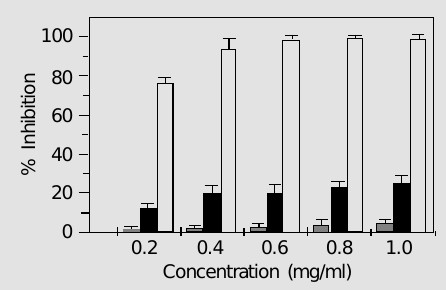
Figure 2. Inhibitory effect of Polypodium leucotomos extract (PL) and kojic acid (KA) (0.0 to 1.0 mg/ml) on the reduction of nitroblue tetrazolium by super- oxide anion radical ( · O 2- ) gener- ated by the hypoxanthine-xan- thine oxidase system. PL (gray bars), KA (black bars), and SOD (light gray bars) used as control.